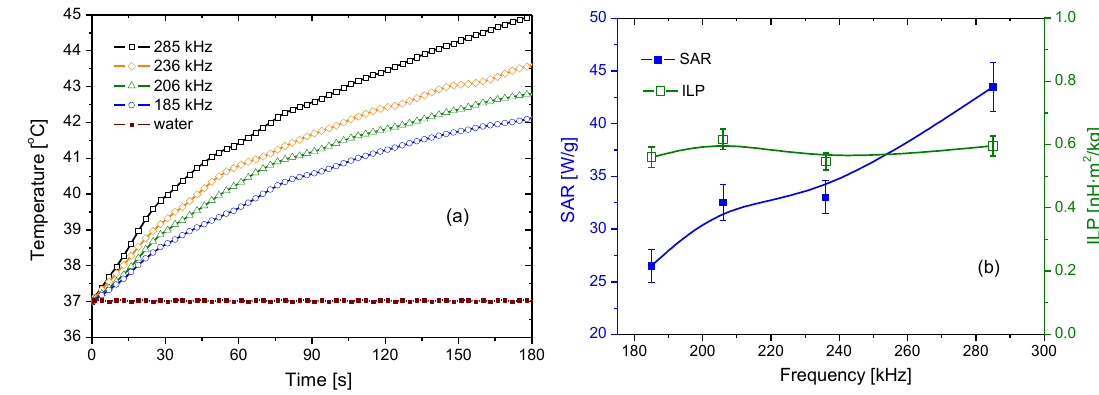
Figure 8. ( a ) Time evolution of the temperature for different frequencies in hyperthermia experiments performed with suspensions containing 10 mg/mL of MagP ® – OH. ( b ) SAR and ILP evaluation. The field amplitude was H 0 = 16.2 kA/m in all the cases.